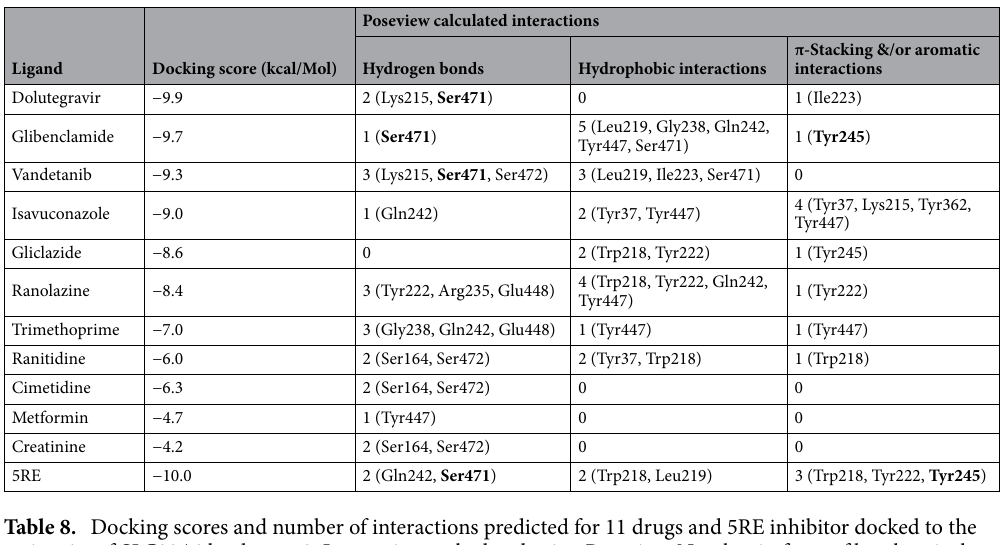
Interactions Hydrogen